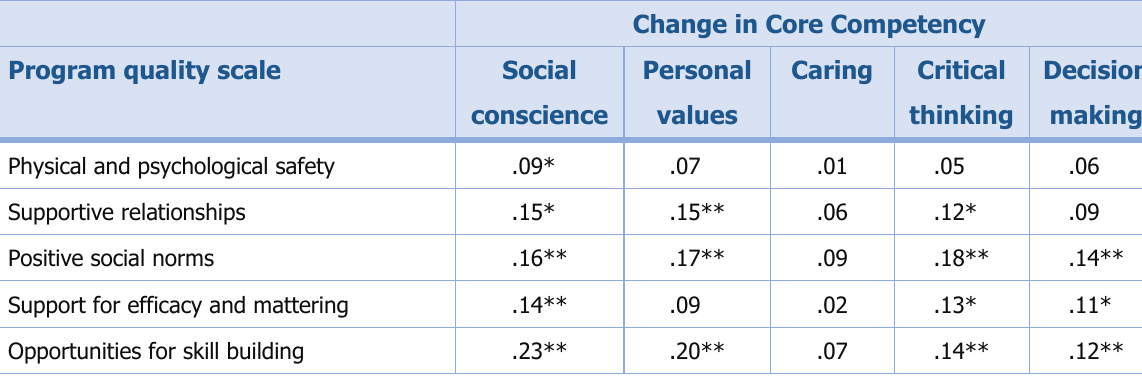
Table 2. Correlations Between Program Quality Scales and Change in Core Competency Change